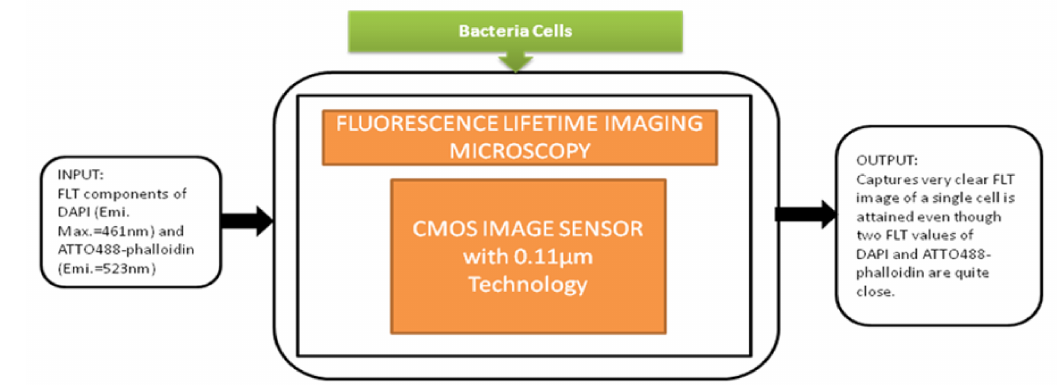
Figure 43. Fluorescence lifetime imaging microscopy is used to capture color fluorescence lifetime images of HeLa cells with DAPI nucleus.